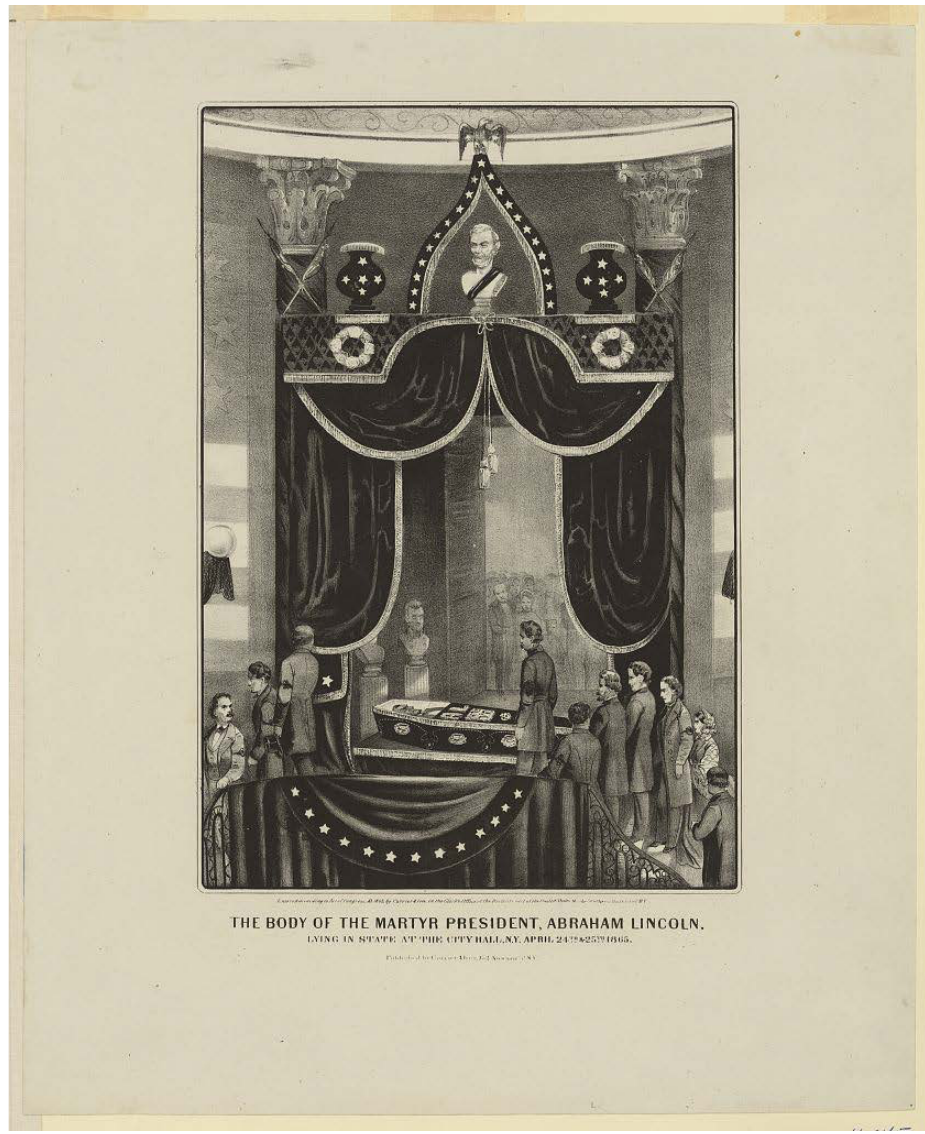
Figure 7 Currier & Ives, The Body of the Martyr Abraham Lincoln Lying in State at the City Hall, New York , April 24th, 25th, 1865. Lithograph. 17.75 x 13 in (19.68 x 33.02 cm). Courtesy of the Library of Congress, Prints and Photographs Division, Washington,